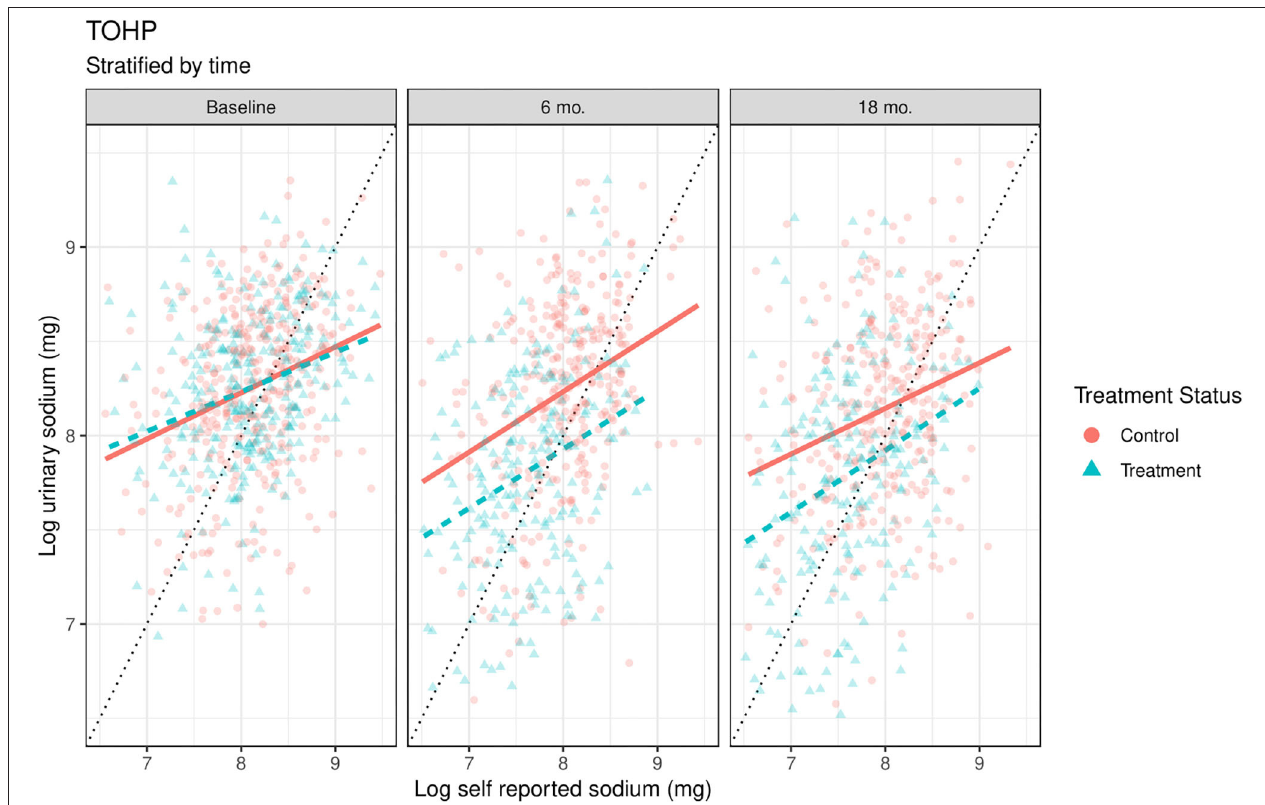
FIGURE 1 | Scatterplots of log urinary sodium vs. log self-reported sodium by time and treatment conditions in TOHP. The solid orange (control) and dashed blue lines (treatment) are linear smoothers of urinary sodium as a function of self-reported sodium in each treatment condition. 45-degree line represents where urinary sodium equals self-reported sodium. Units are on the natural log